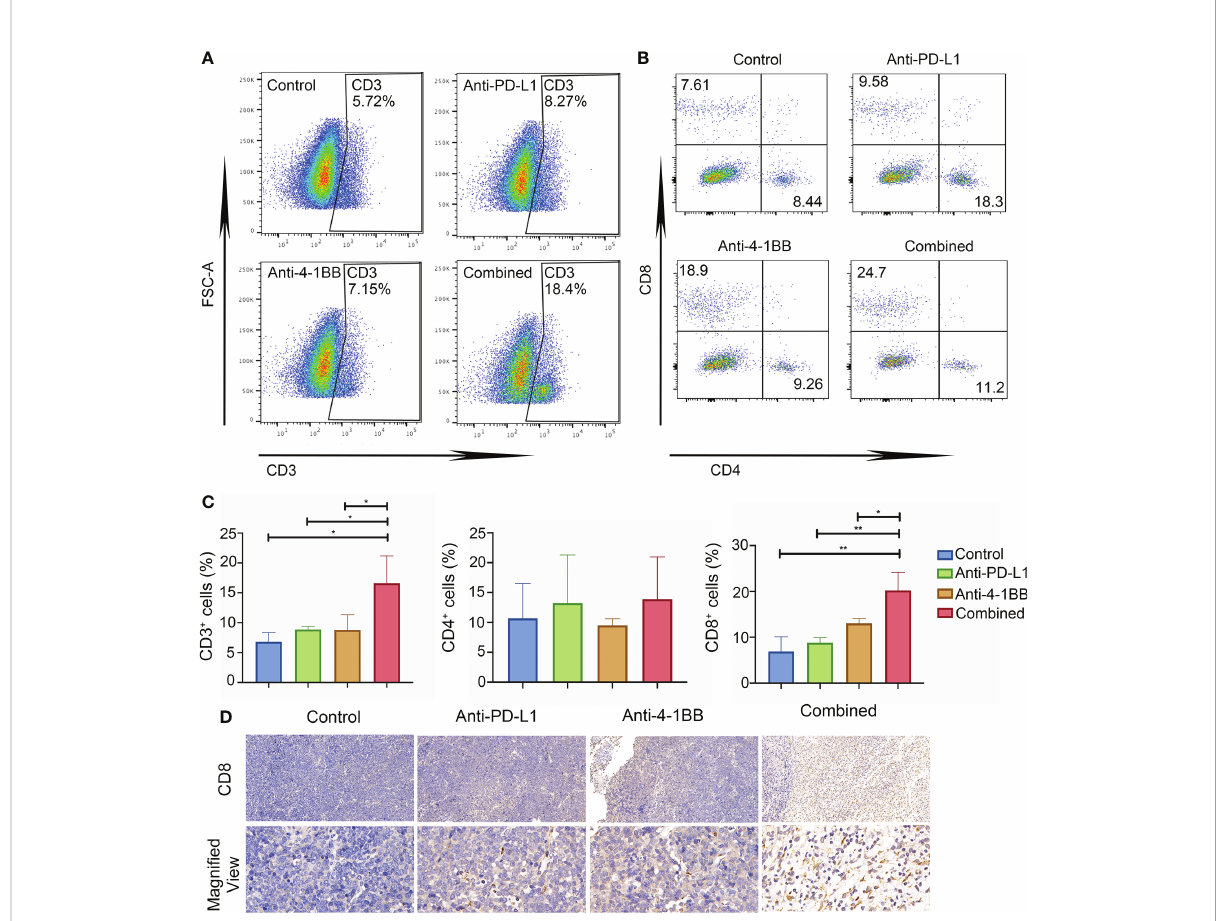
FIGURE 3 The combined therapy increased cytotoxic T-cell in fi ltration and expression of PD-L1. (A – C) The proportion of CD4/CD8 positive cells in the tumor tissue in each group (n = 3) after one week of treatment. (D) The in fi ltration of CD8 + T cell in tumor tissue detected by Immunohistochemistry (IHC) (Magni fi cation × 20 (up), Magni fi cation × 90 (below)). * means p-value < 0.05, and ** means p-value <